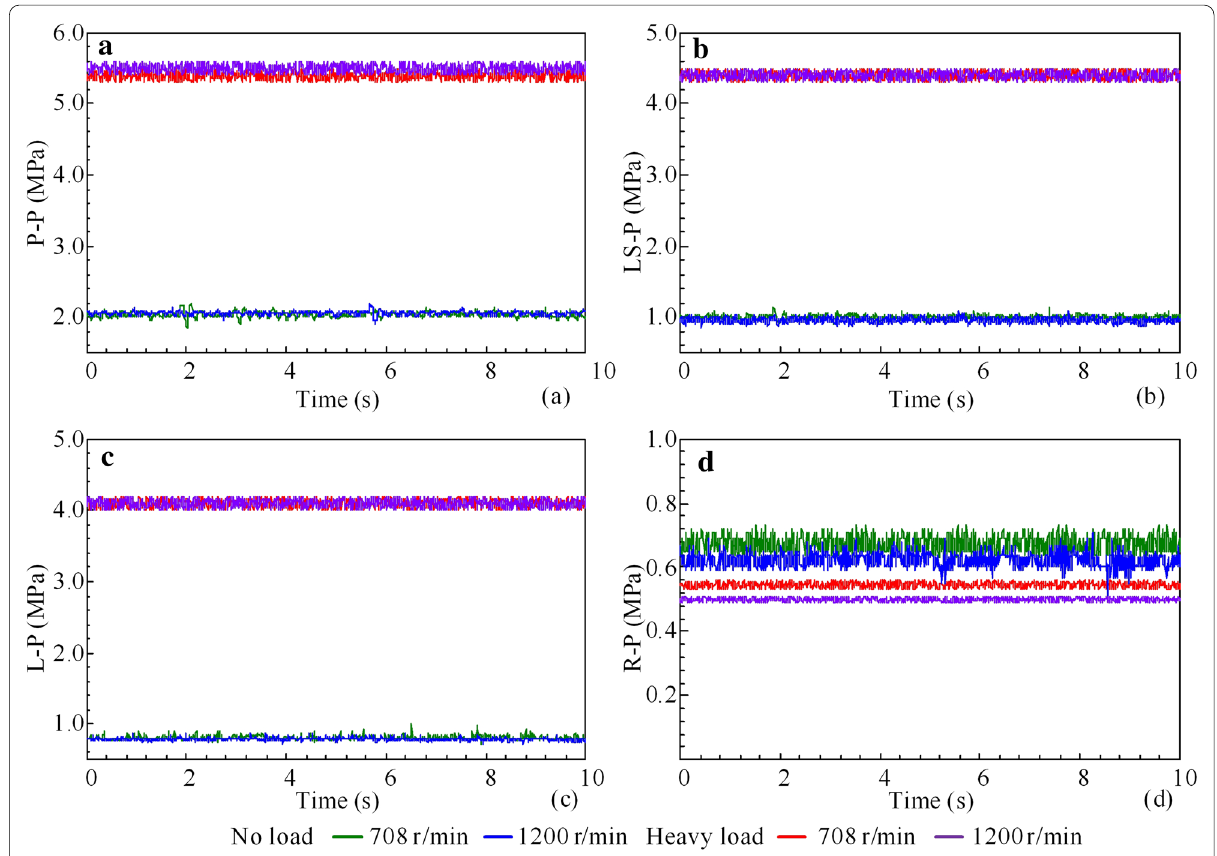
Figure 14 Experimental results under steering wheel speed of 8 r/min and electromotor speed of 708 r/min: a P , b P LS , c P L , and d P R